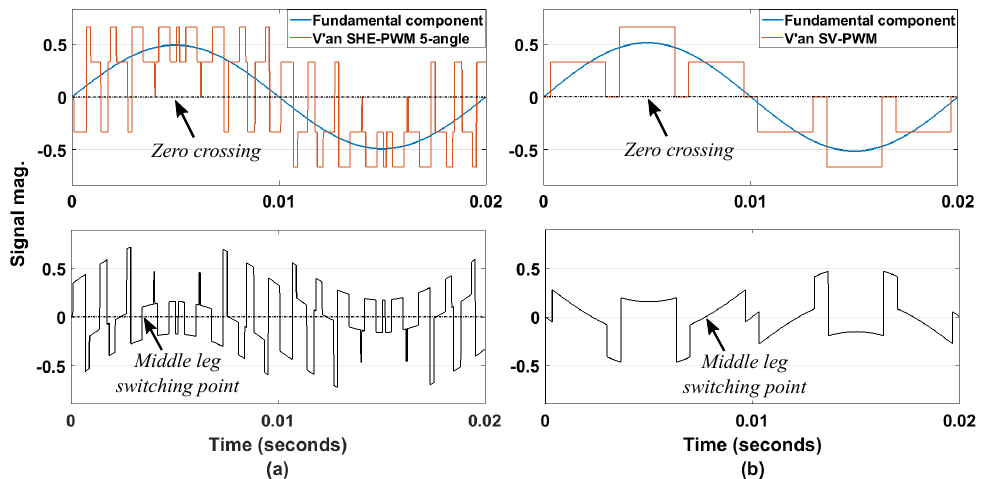
Figure 2. Signal comparison for harmonic compensation reference signal calculation. ( a ) SHE- PWM as a modulation strategy for 3-phase converter. ( b ) SV-PWM as a modulation strategy for 3-phase